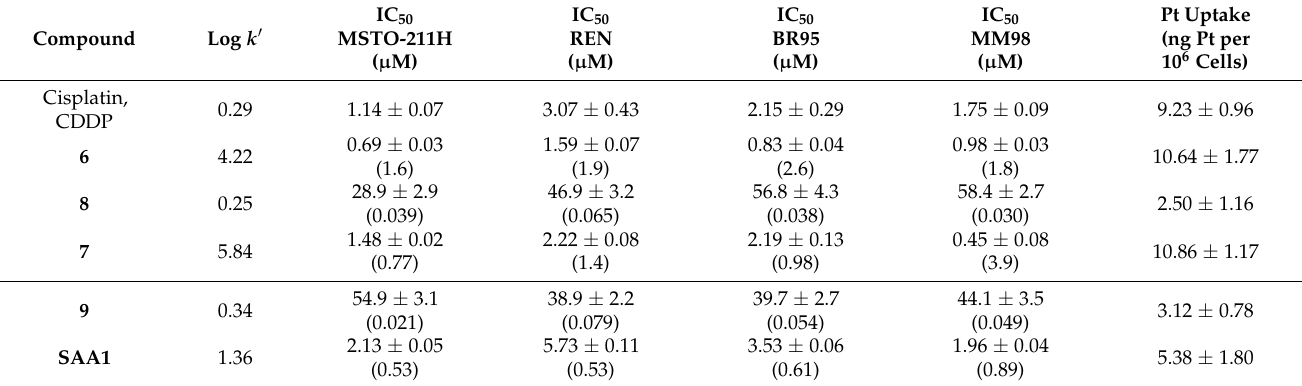
Table 1. Lipophilicity (log k (cid:48) ), Pt uptake (ng Pt per 10 6 MSTO-211H cells), and antiproliferative (IC 50 , µ M) data for complexes 6 – 9 together with cisplatin, CDDP, and SAA1 . IC 50 data were obtained after 72 h of treatment of the malignant pleural mesothelioma cancer cell lines MSTO-211H (mixed or biphasic phenotype), REN (epithelioid), BR95 (epithelioid), and MM98 (sarcomatoid). Data are means ± standard deviation (sd) of at least three independent replicates. Numbers in parenthesis are the ratios IC 50 (cisplatin)/IC 50 (Pt(IV)